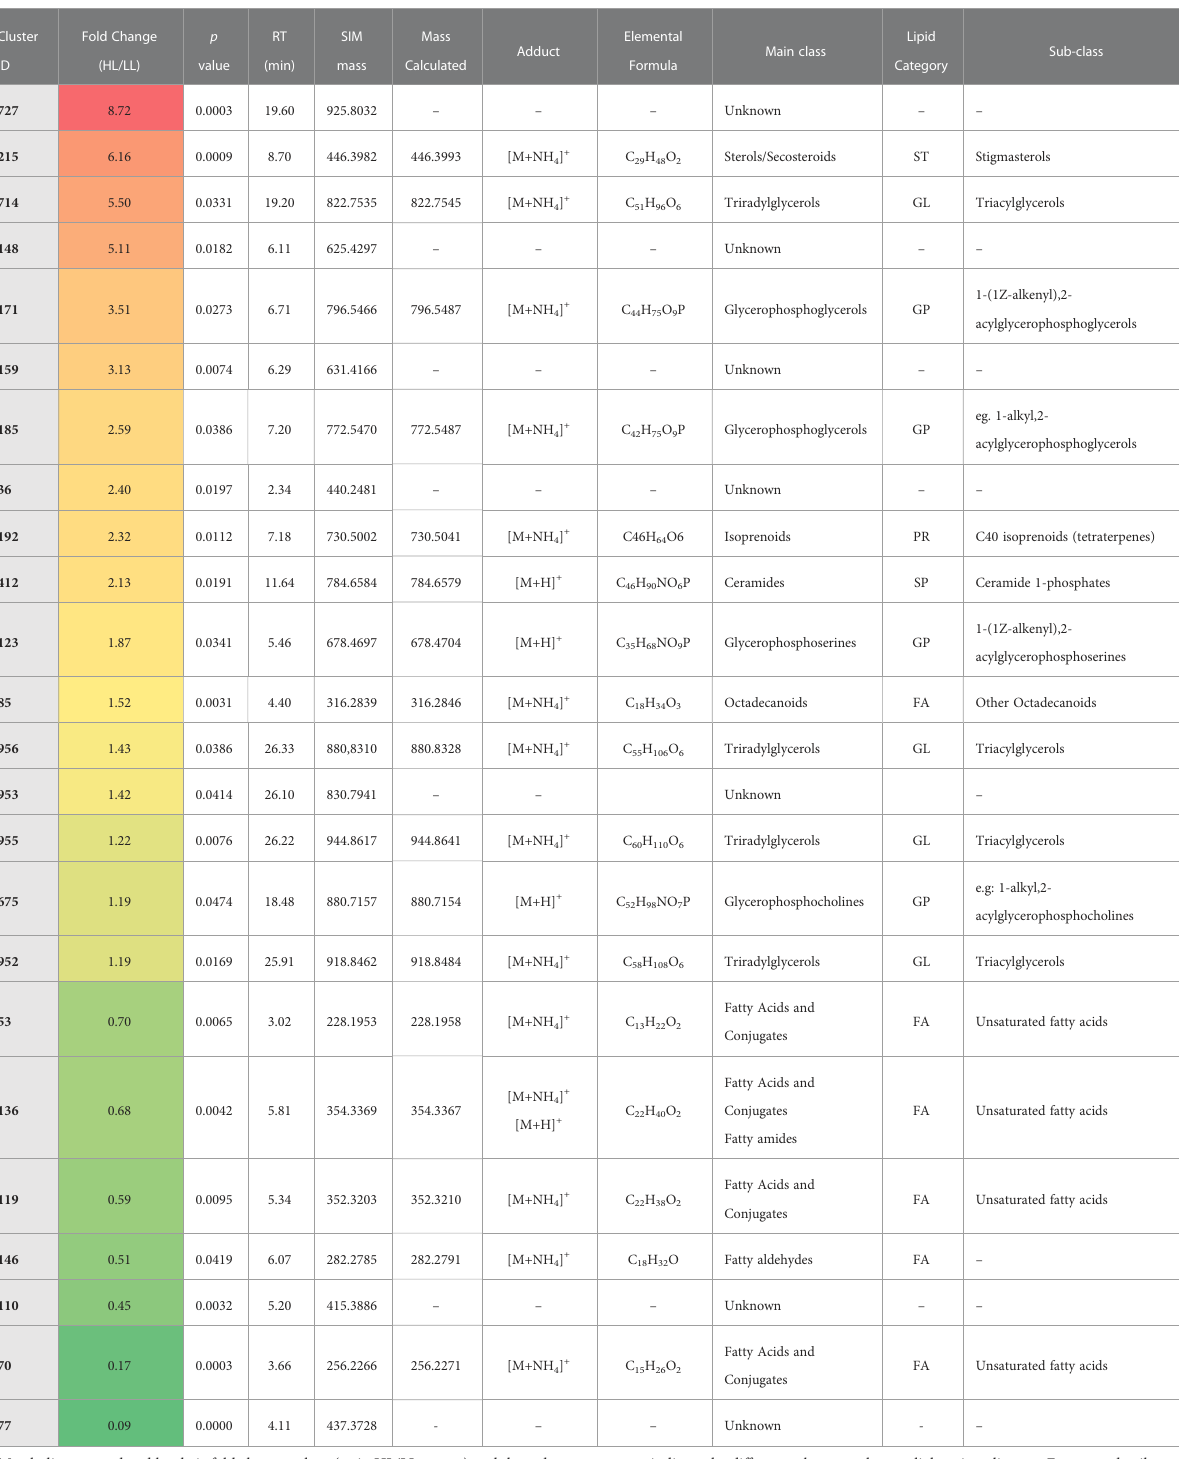
TABLE 3 List of putatively annotated seed lipids with statistical differences between low light (LL) and high light (HL) microclimates at mature stage of berry development (Student ’ s t-test, p ≤ 0.05).